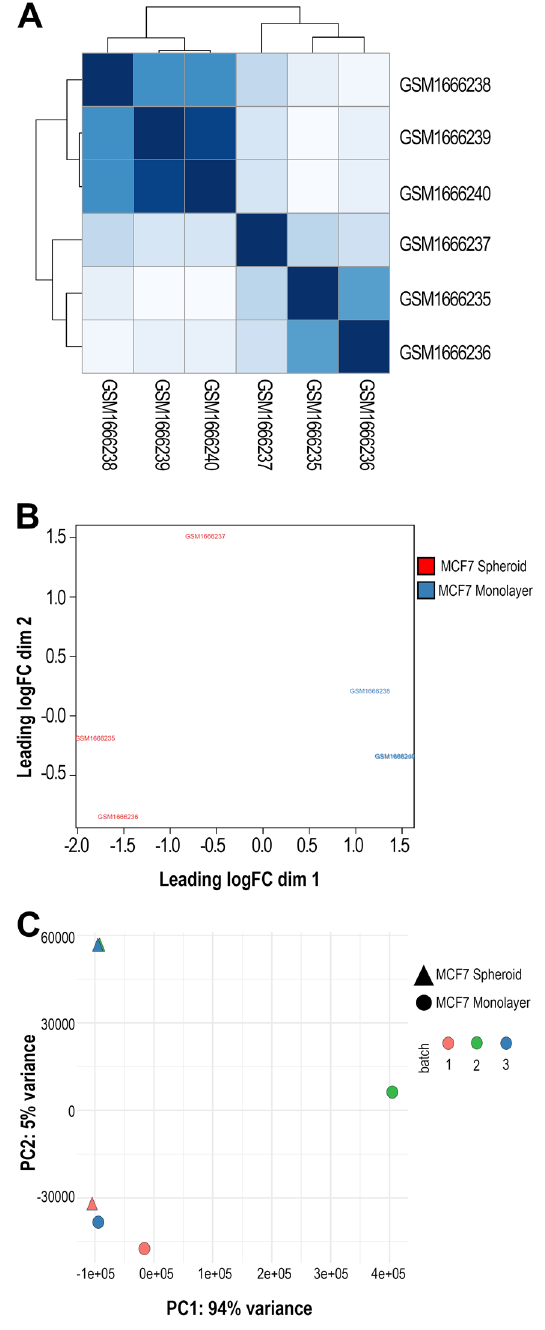
Figure 4. Sample group clustering plots. A ) Correlation plot showing samples’ distances in GSE68246 dataset. The darker the colour, the more correlated they are. B ) Multidimensional Scaling (MDS) plot using all the sequenced data and one of the normalisation methods applied in the workflow (in this case, TMM) made with plotMDS() function from EdgeR. In black and brown are shown the two different groups (monolayer and spheroid). C ) Principal Components Analysis (PCA) plot displaying the first two Principal Components using all the sncRNA molecules data. Each sample is shown with different colours (depending on the group) and different symbols (depending on the batch).